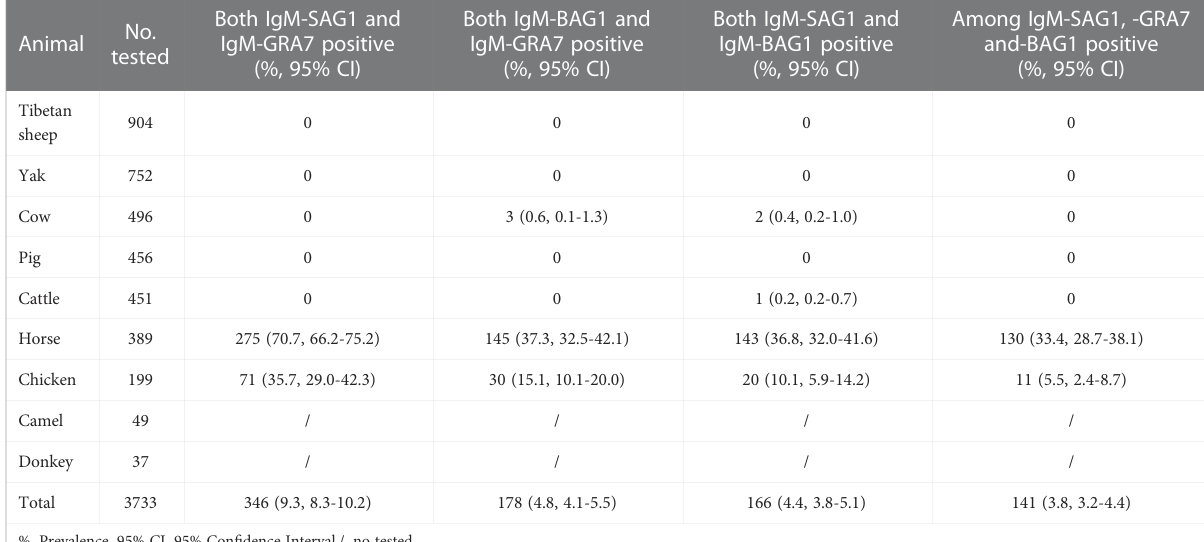
TABLE 4 Speci fi c- T. gondii IgM-positive animals based on among SAG1, GRA7 and BAG1 proteins. Both IgM-SAG1 and Both IgM-BAG1 and No. Animal tested